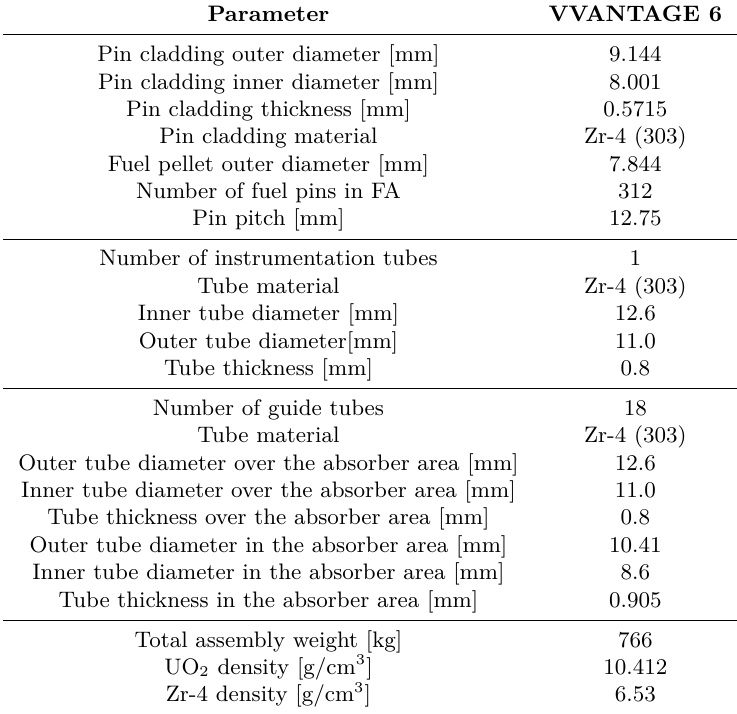
Table 1. Fuel assembly parameter summary